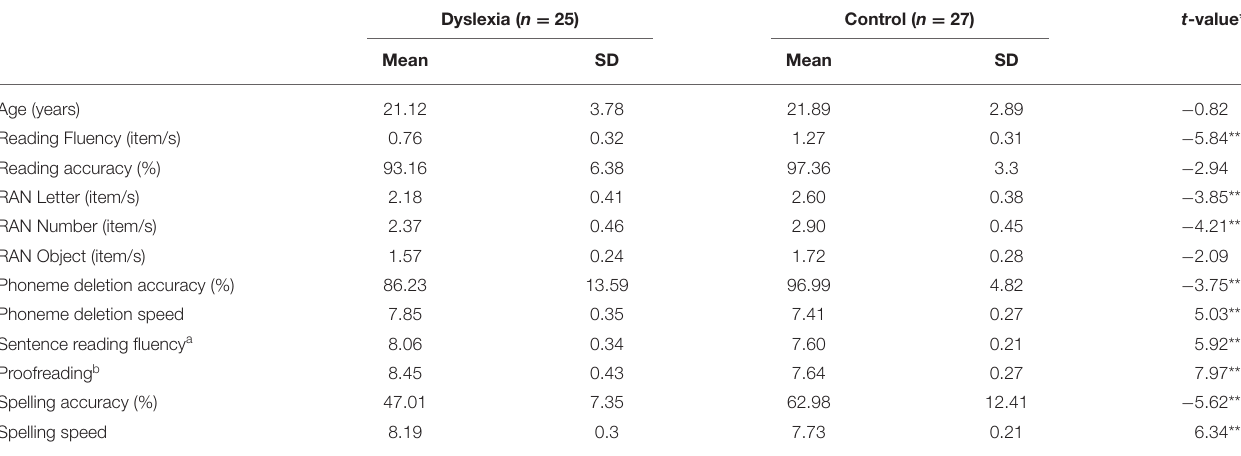
TABLE 1 | Descriptive statistics of participants with and without dyslexia and group differences ( t